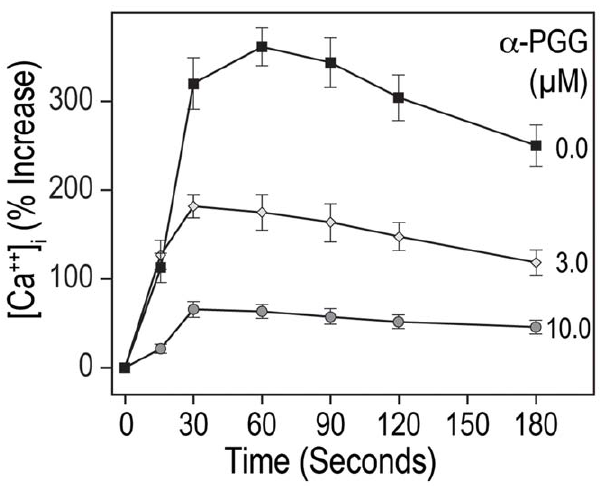
Figure 5. a -PGG inhibited collagen-induced phosphorylation of Akt. Washed human platelets were stimulated with collagen (1.0 m g mL 2 1 ) in the presence or absence of a -PGG (10 m M). Lysis buffer was added to samples at 6 min to terminate reactions. Total Akt and p-Akt were visualized after PAGE and Western blotting as described in the Experimental Procedures. The b -actin was used as a loading control.